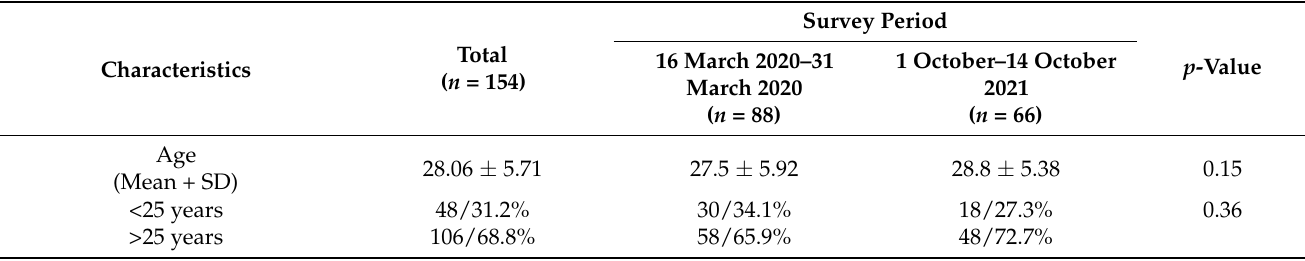
Table 1. The characteristics of participants evaluated between 14 March 2020 and 31 March 2020, and between 1 October2021 and 14 October